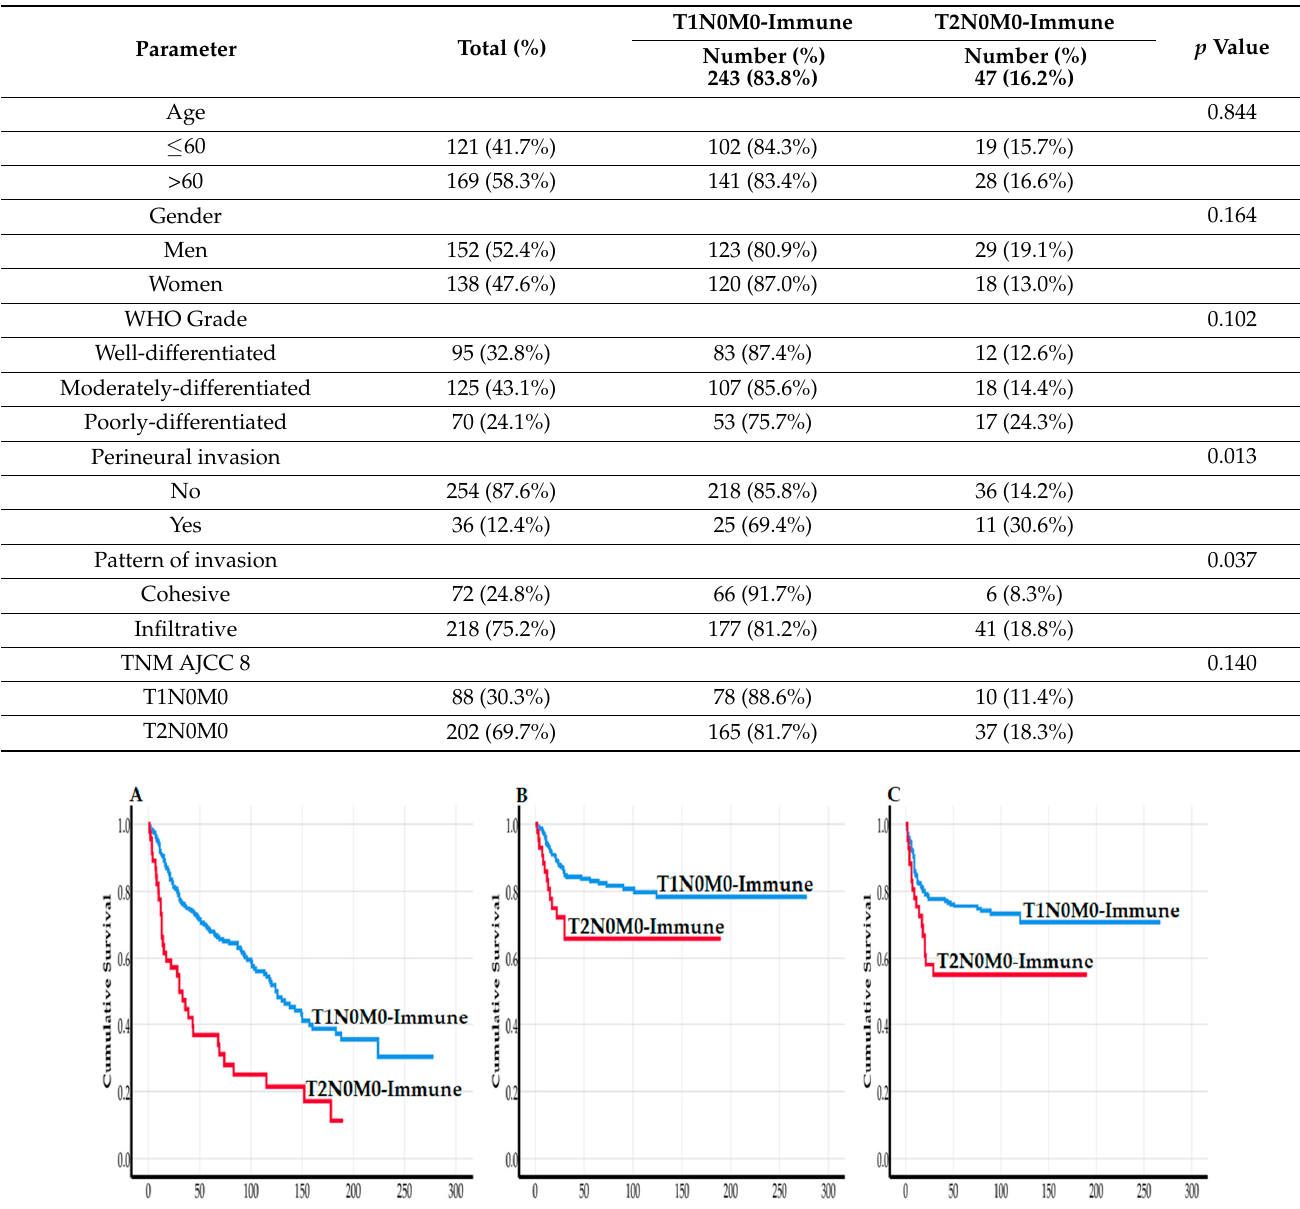
Table 1. Relationship between our proposed TNM-Immune (TNM-I) system and the clinicopathologic characteristics of 290 patients treated for early-stage (AJCC 8) oral tongue cancer.